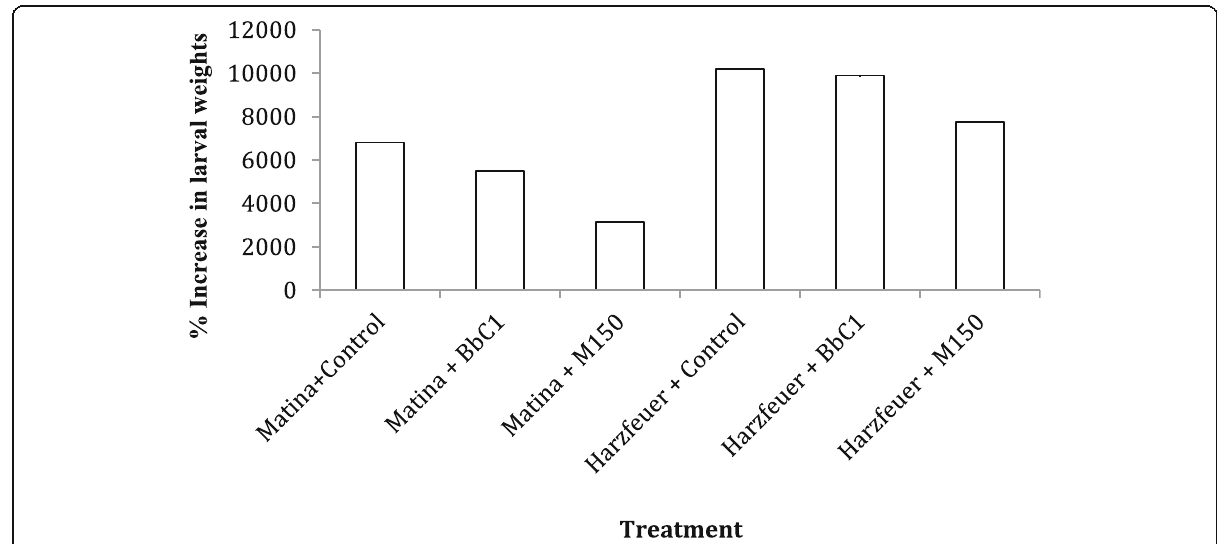
Fig. 2 Percent increase in weight of Spodoptera frugiperda larvae after 3wks of feeding on Beauveria bassiana (BbC1) and Metarhizium (M150) root-inoculated tomato (Matina and